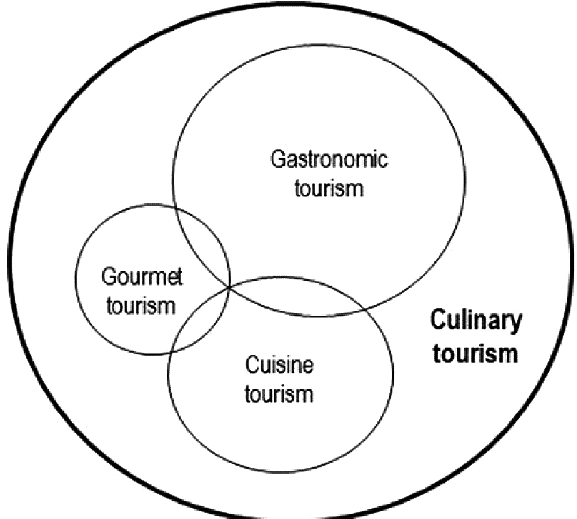
Fig. 2. Forms of culinary tourism by Matlovičová and Pompura